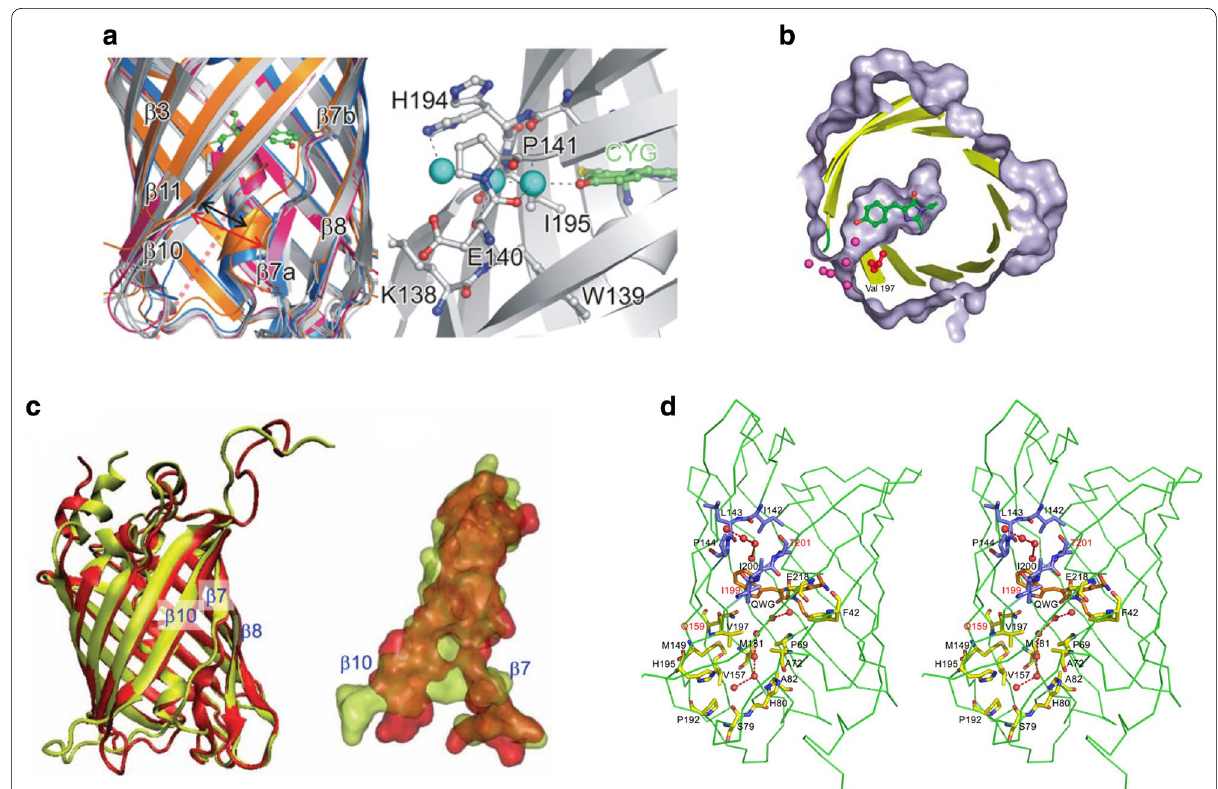
Fig. 10 Cleft‑like channels filled with water (oxygen) molecules in the β ‑barrel frame between β 7 and β 10 sheets of DronPa ( a ) (Reproduced from [106] with the permission of Portland Press Ltd.), TurboGFP ( b ) (Reproduced from [107] with the permission of John Wiley and Sons), mCherry ( c ) (Reproduced from [95] with the permission of AIP Publishing LLC.), and KillerOrange/mKillerOrange ( d ) (Figure from [108] and Creative Commons license). a DronPa: The cleft (indicated by the broken line) near to strand β 7 is conserved. The red double headed arrow indicates the width of the cleft. Water molecules are shown as the cyan spheres, building hydrogen‑bonded connection between the chromophore and the aqueous environment. The protein region around the opening and the chromophore is shown as the ball‑and‑stick model. b TurboGFP: A pore leading to the TurboGFP chromophore. The chromophore is highlighted in green and Val 197 in red. The protein surface (gray) is cut to show the pore and the chromophore cavity. The sections of secondary structure elements are shown as the yellow cartoons. Relevant water molecules are depicted as the magenta spheres. c mCherry: The superposition of ribbon structures of red (mCherry) and yellow (citrine) fluorescent proteins. The β 7– β 10 region is displayed with a space filling model to show that the gap in mCherry is larger than that in citrine. d KillerOrange (dimer) and mKillerOrange (mono‑ mer): The pore is filled by four water molecules connecting the indole moiety of the chromophore with the protein exterior. The water channel (resi‑ dues shown in yellow) with a chain of seven water molecules (red spheres) and the pore (residues shown in blue) filled with four water molecules. The residues mutated in this work are labeled in